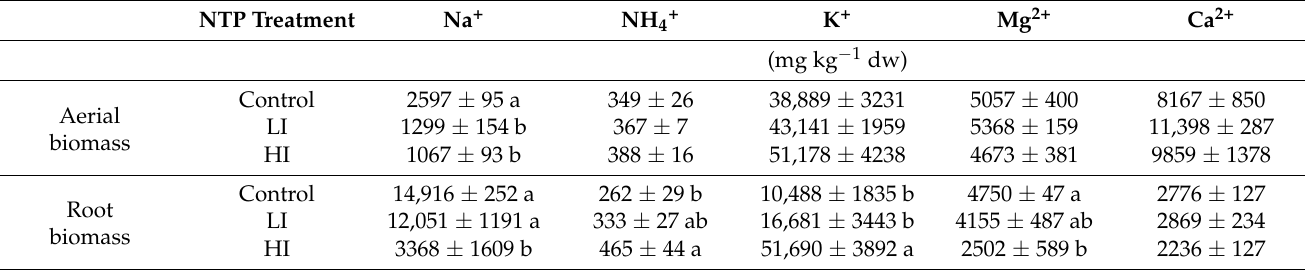
Table 4. Effect of non-thermal-plasma-activated nutrient solution on the content of anions and cations in the aerial and root biomass of